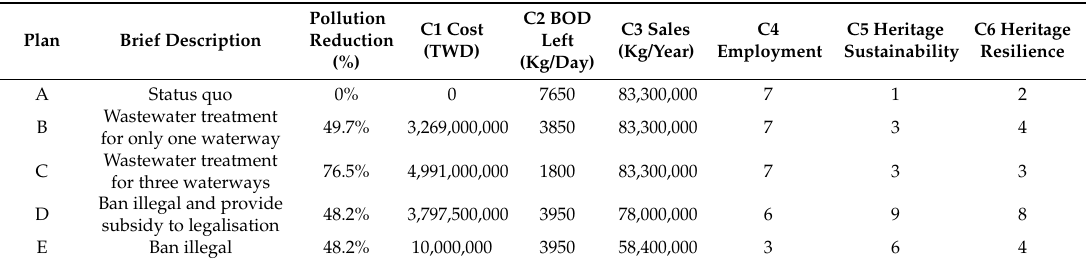
Table 4. Raw values/scores of the alternatives.